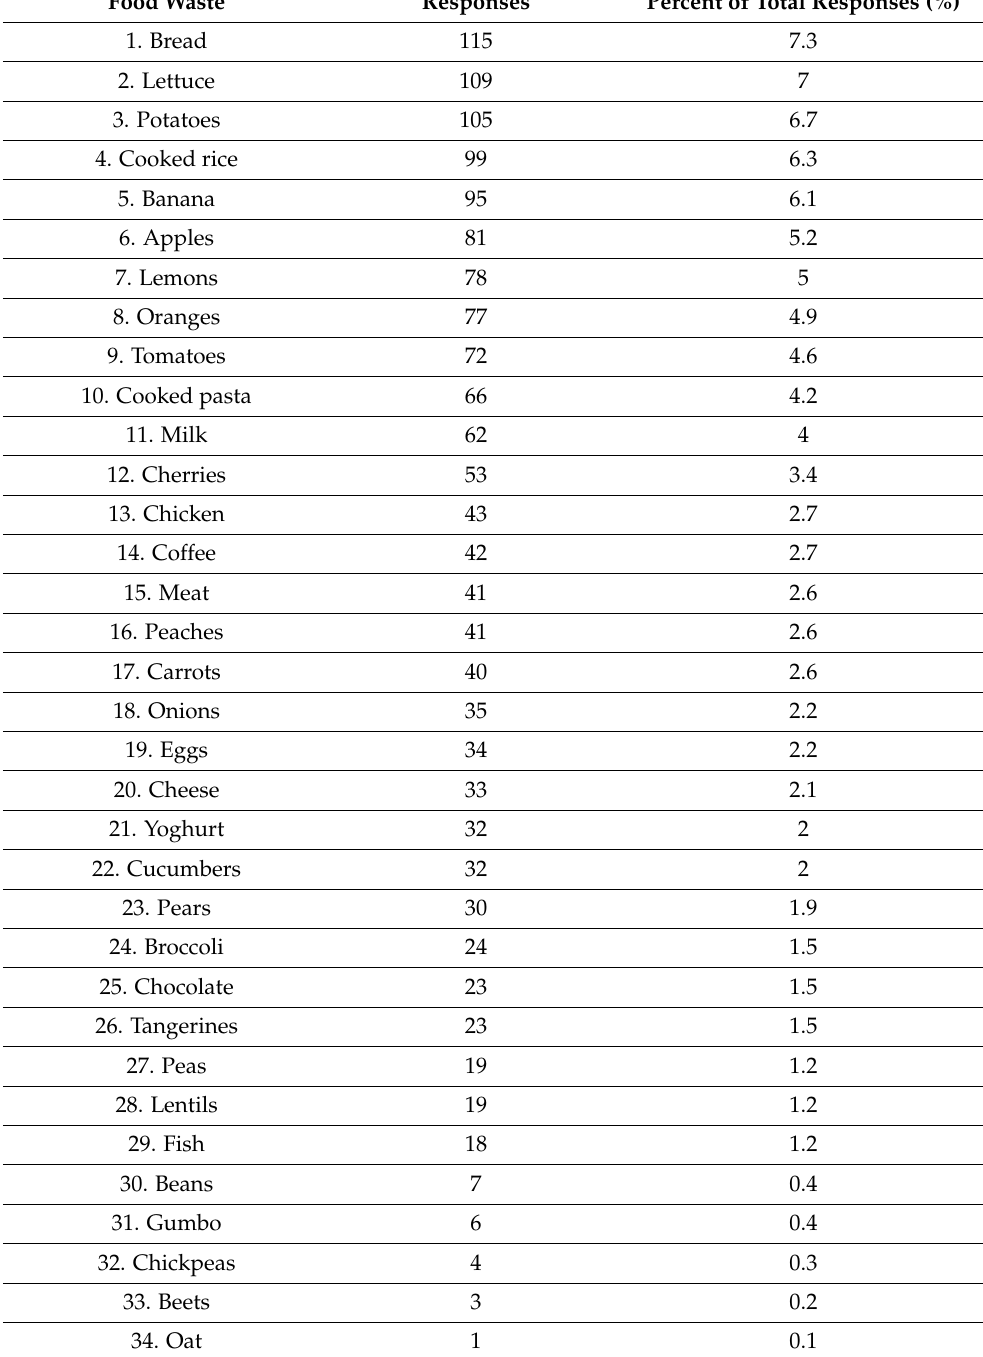
Table 3. Most usual household food waste in Greece based on consumers’